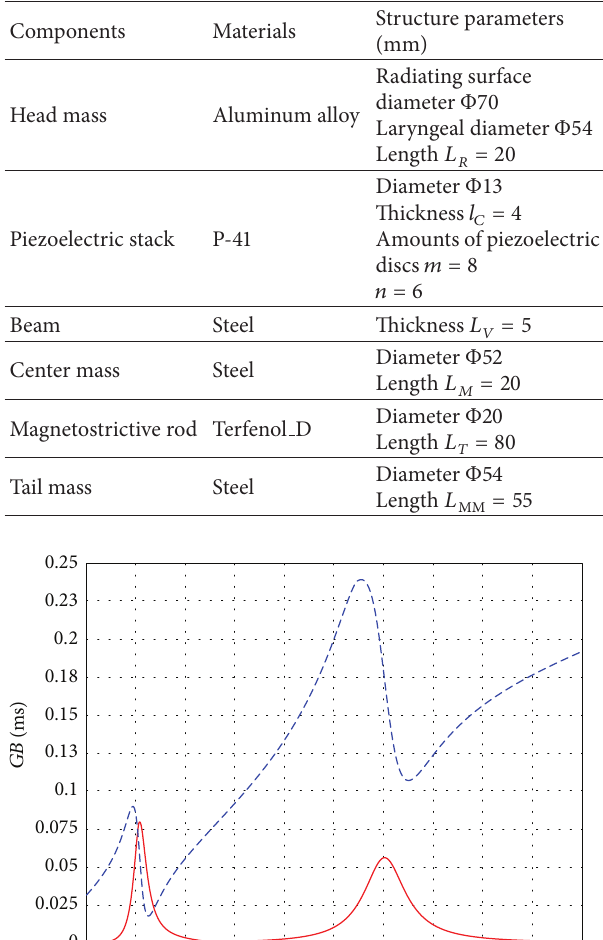
Table 1: The materials and sizes of the Hybrid transducer’s main components.